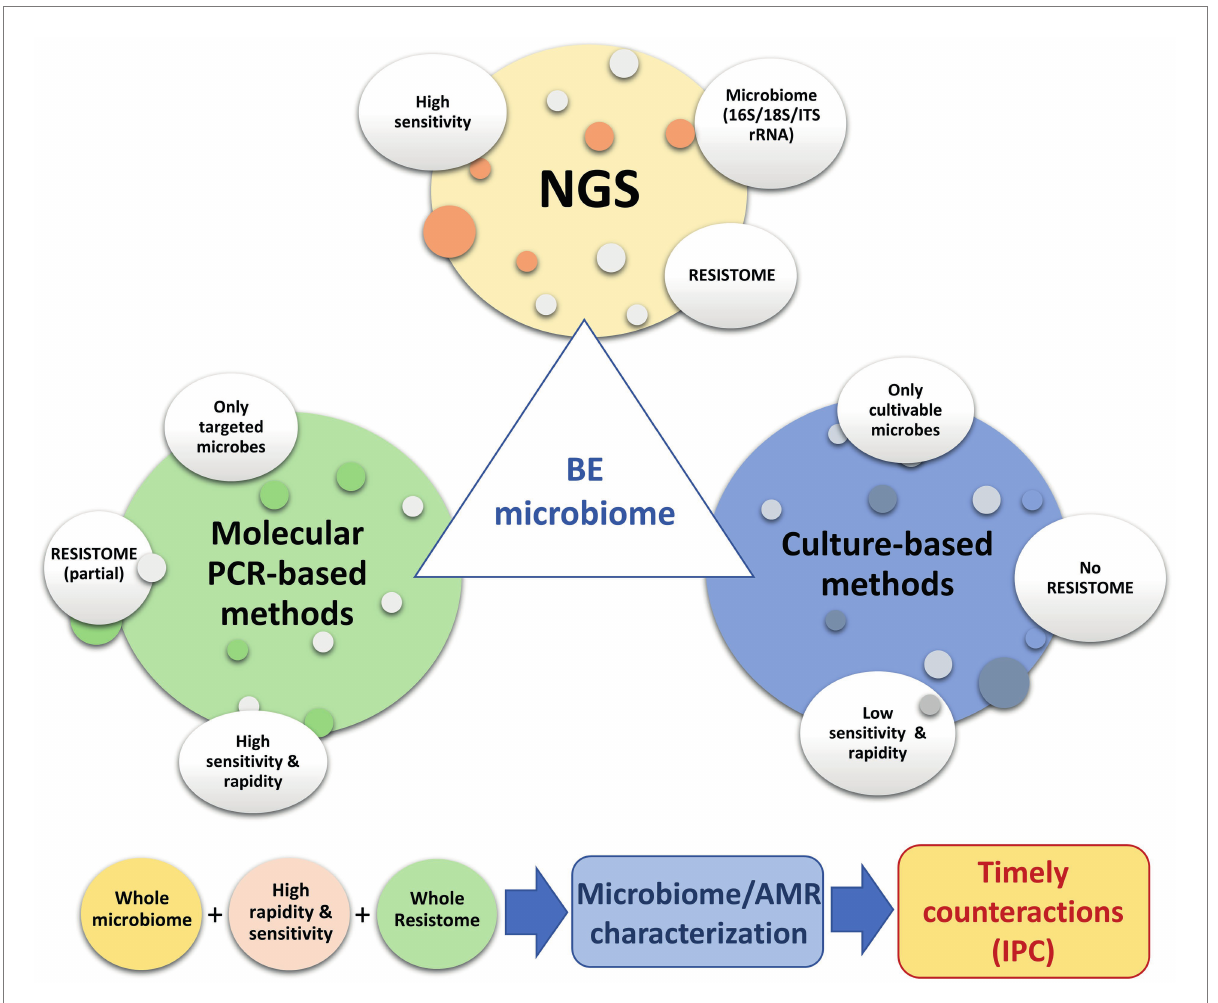
FIGURE 2 Use of different molecular and conventional methods to depict the microbiome of the hospital environment, with particular focus on AMR